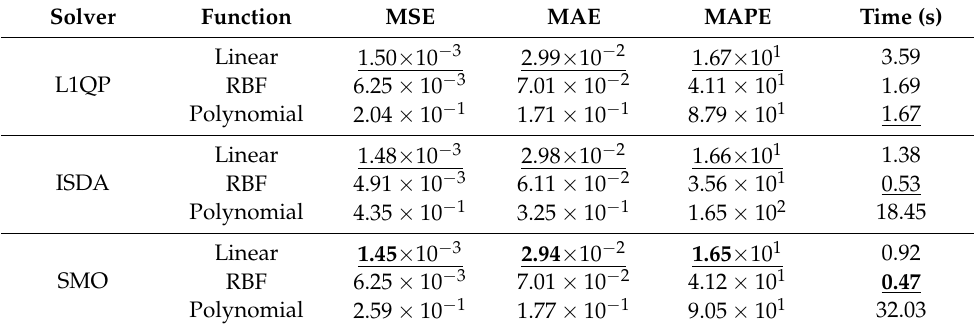
Table 5. Evaluation of stacking ensemble learning